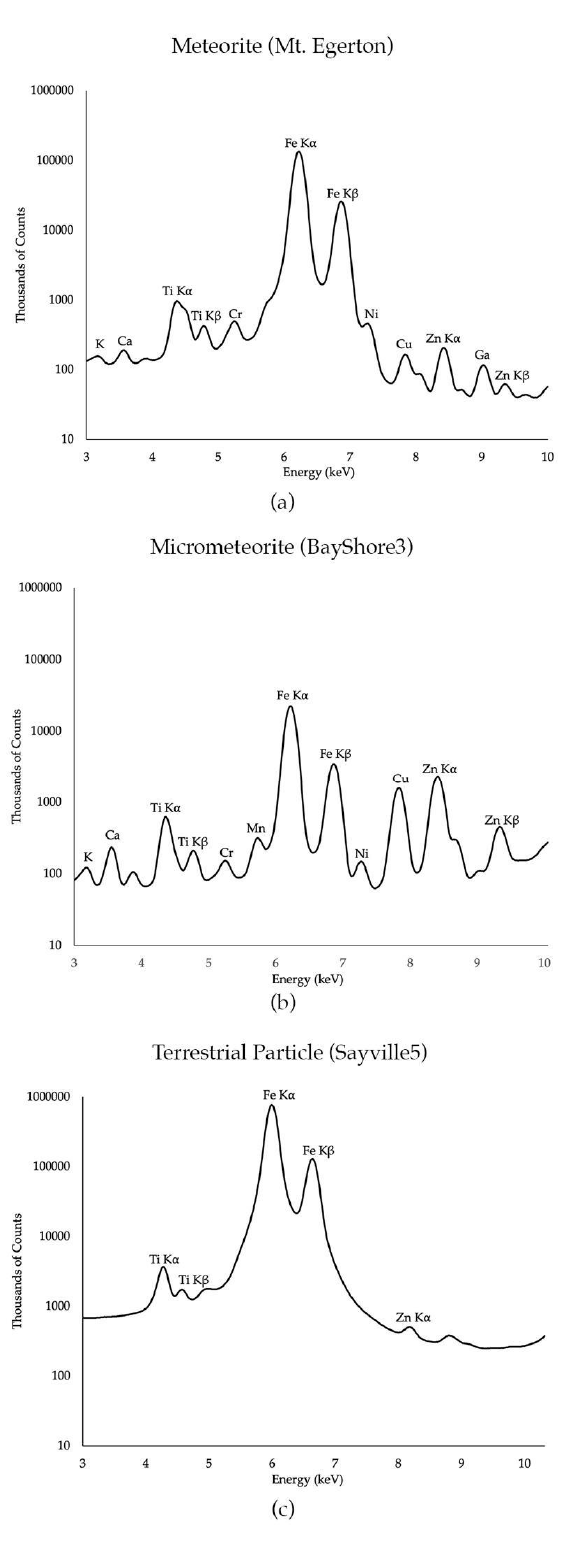
Figure 4. X-ray fluorescence (XRF) spectra of elements present in ( a ) Mt. Egerton (Aubrite) meteorite; ( b ) BayShore3 collected particle identified as a micrometeorite and classified as a cosmic spherule (CS), and ( c ) Sayville5, collected particle identified as terrestrial origin. Fluorescence peaks for those elements identified are labeled. Note the similarity between the elements identified and their relative counts for ( a ) meteorite and ( b ) micrometeorite while ( c ) the terrestrial particle has an absence of Ni and higher counts of Ti and Fe as compared to the extraterrestrial particles.